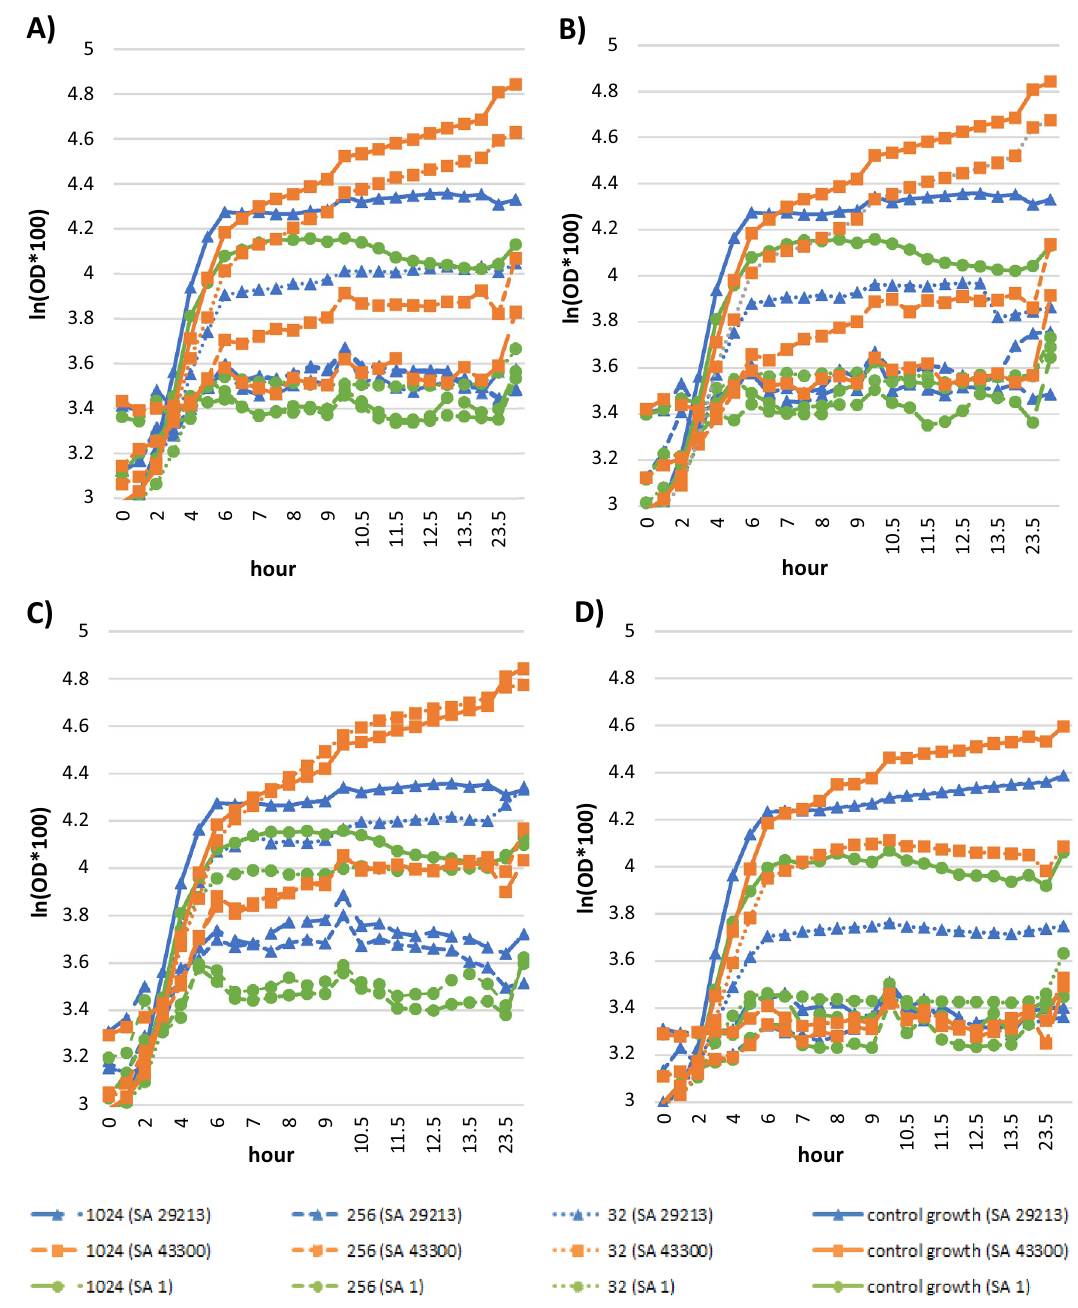
Figure 1. Growth curves of Staphylococcus aureus strains upon different concentrations of hydrolyzed palm oils or lauric acid (( A )— Astrocaryum vulgare oil; ( B )— Cocos nucifera oil; ( C )— Elaeis guineensis oil; ( D )— lauric acid) determined spectrophotometrically. SA Staphylococcus aureus , OD optical